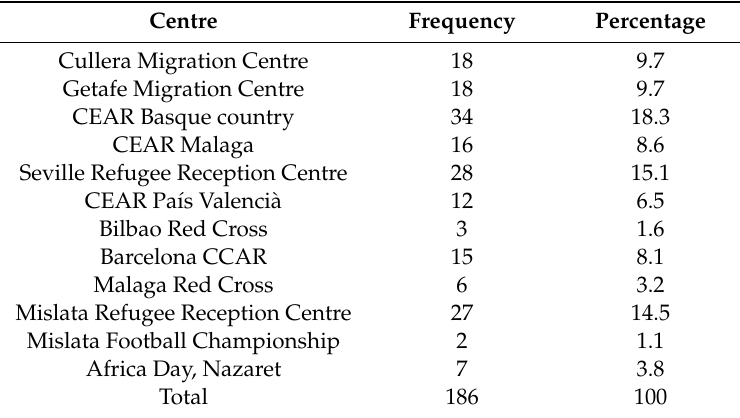
Table 1. Location of the interviewed